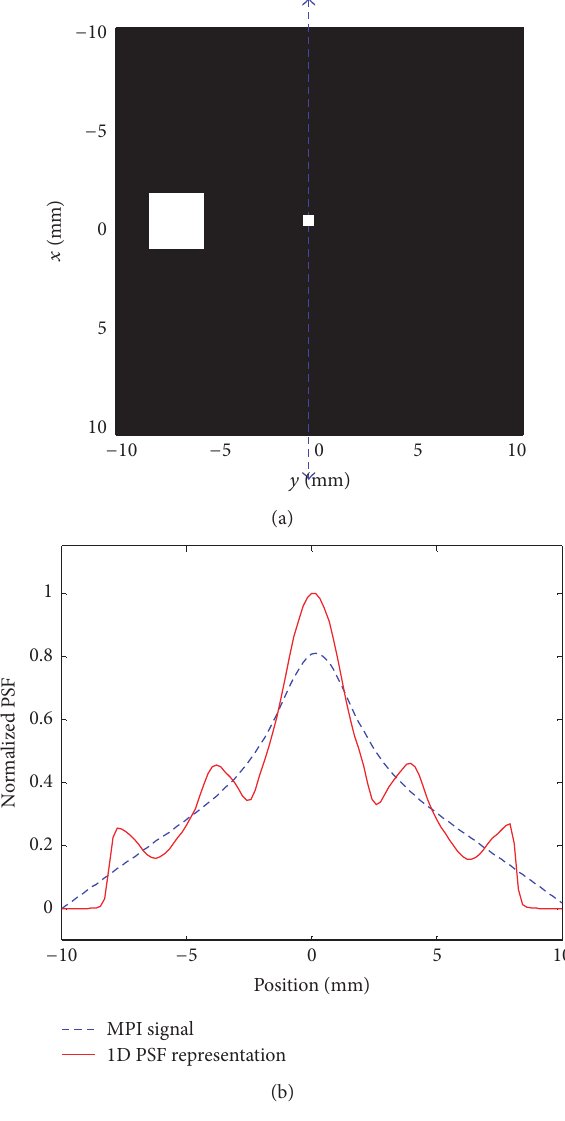
Figure 4: Image representation by 1D PSF: (a) 2D distribution of particles and the position of the drive field; (b) representation of the image signal based on 1D